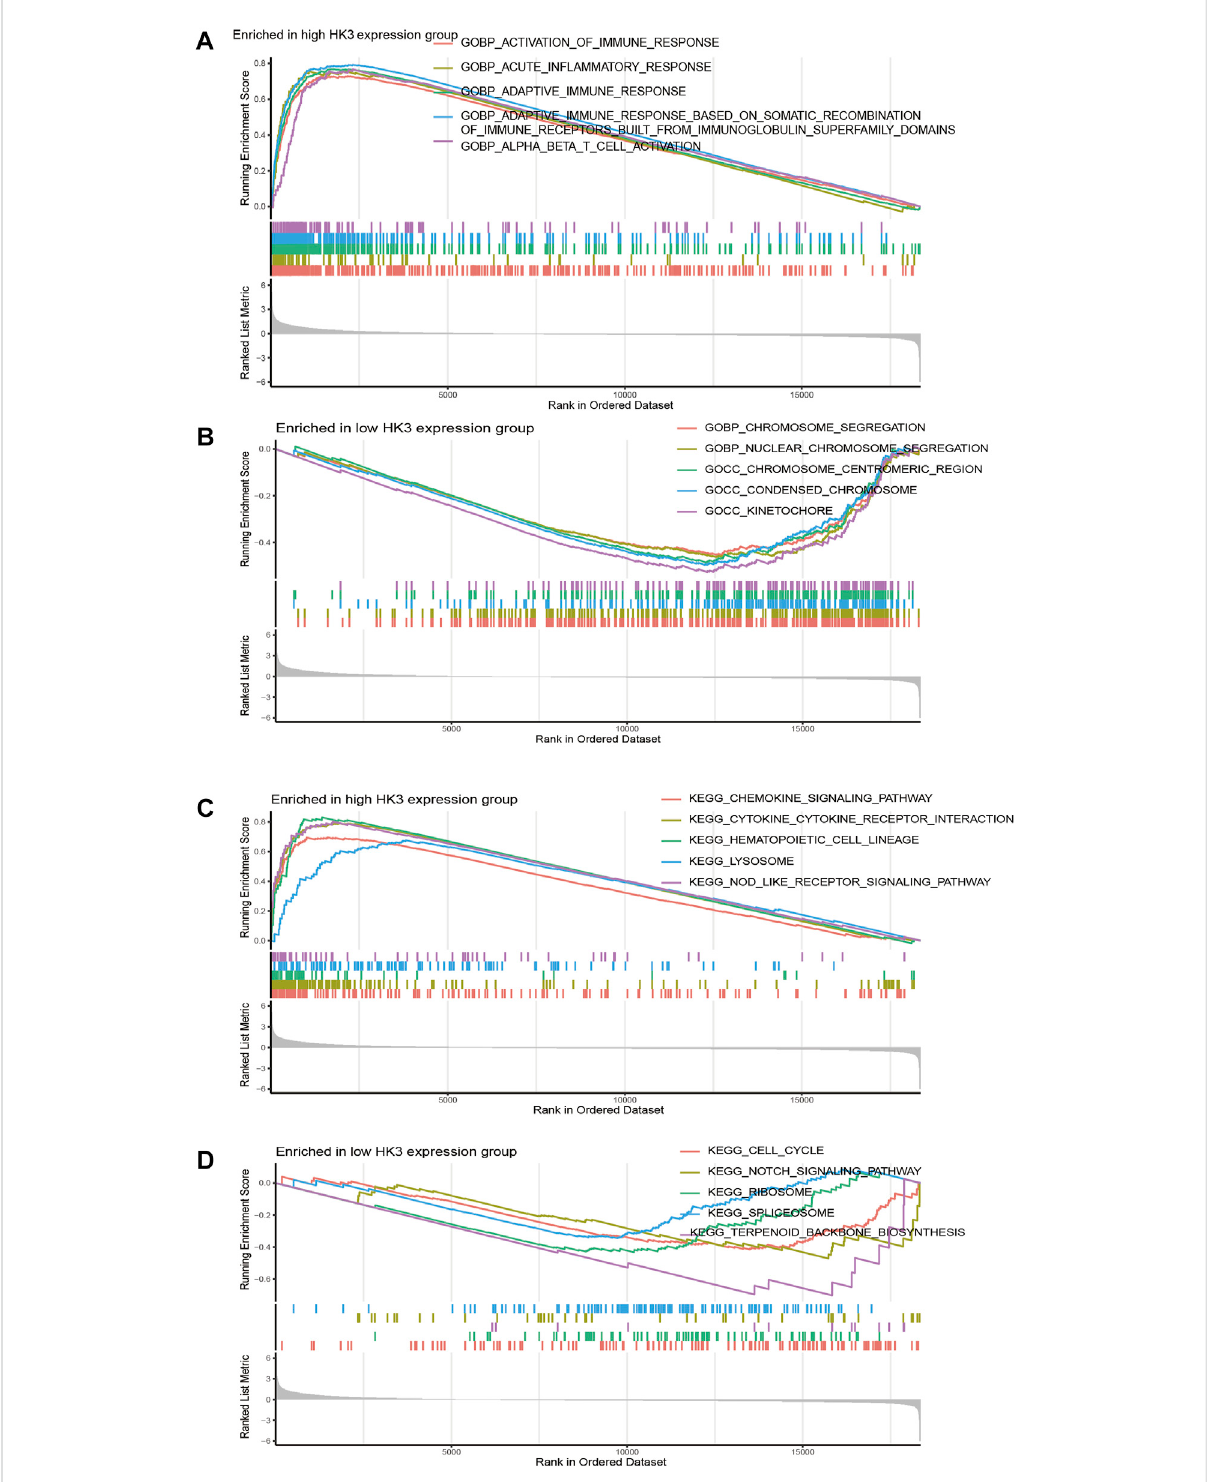
FIGURE 4 FunctionenrichmentanalysisinGBM. (A,B) Thetop fi veGOitemsenrichedinthehigh-andlowHK3expressiongroups. (C,D) Thetop fi veKEGG items enriched in the high- and low HK3 expression